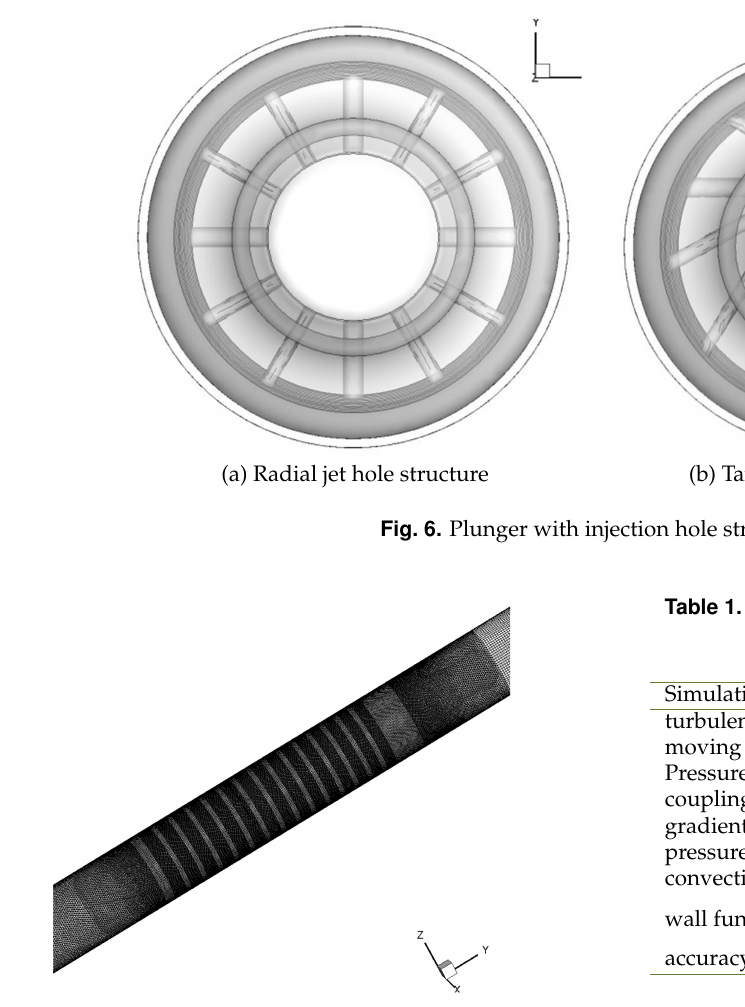
Table 2. Boundary conditions for